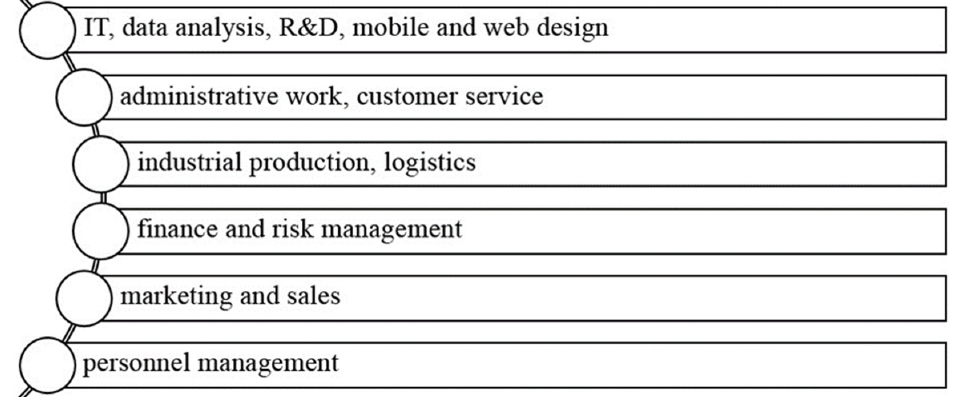
Figure 2. Areas of activity most sensitive to the availability of soft skills. Source: the authors based on data from (Kyllonen 2013).